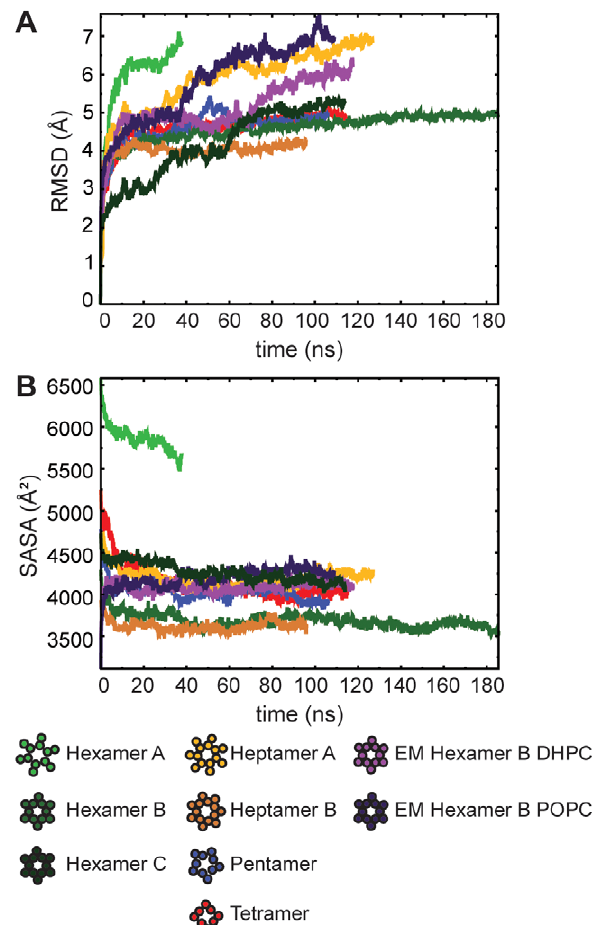
Figure 2. Time-evolution of the structural parameters of the oligomers. Distance root-mean square deviation (RMSD) with respect to the starting conformation of the p7 channel, computed over backbone atoms (A), and solvent-accessible surface area (SASA) per subunit (B).